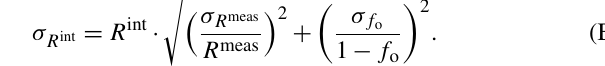
angles f 1 and f 2 of the penumbral and (ant)umbral shadow, respectively, are also published as Besselian elements. Note that l 2 is positive for annular eclipses and negative for total eclipses, while l 1 is always